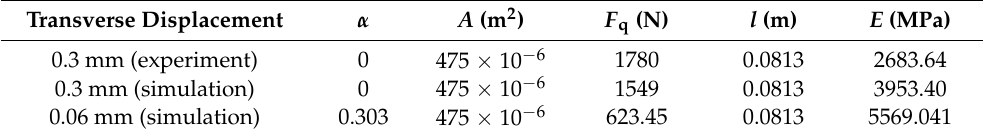
Table 2. Parameters of the equivalent model under different transverse displacements.